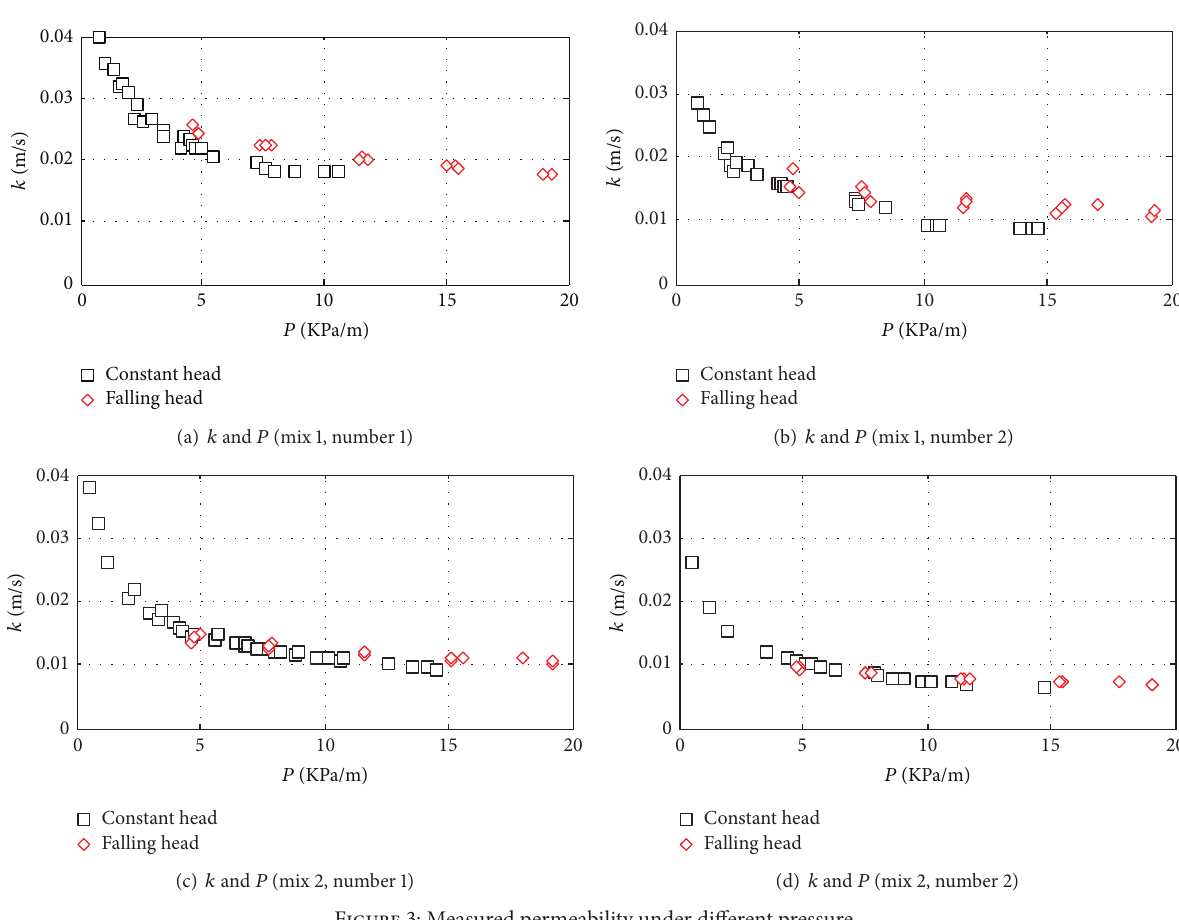
Figure 3: Measured permeability under different pressure. Table 1: The Klinkenberg coefficient and basic properties of the pervious concrete